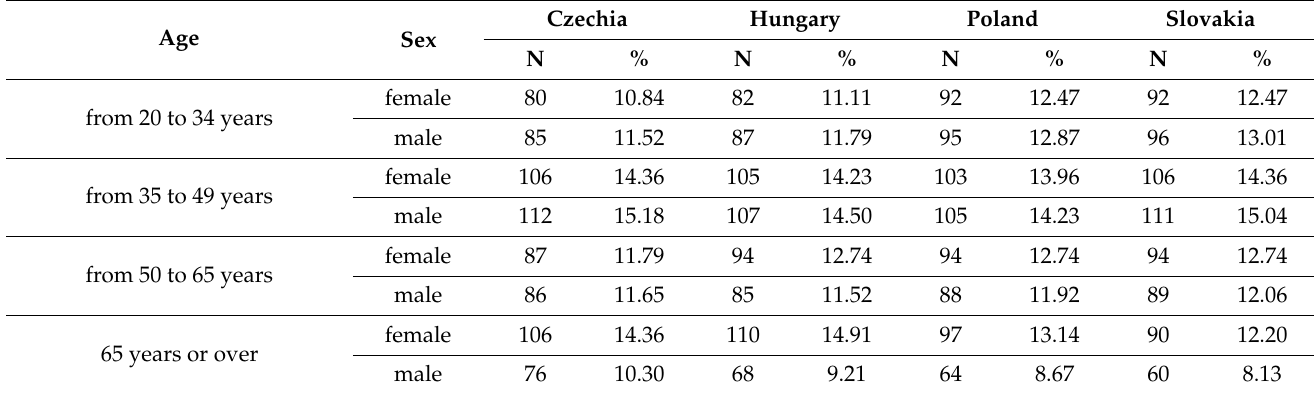
Table 1. Characteristics of the research